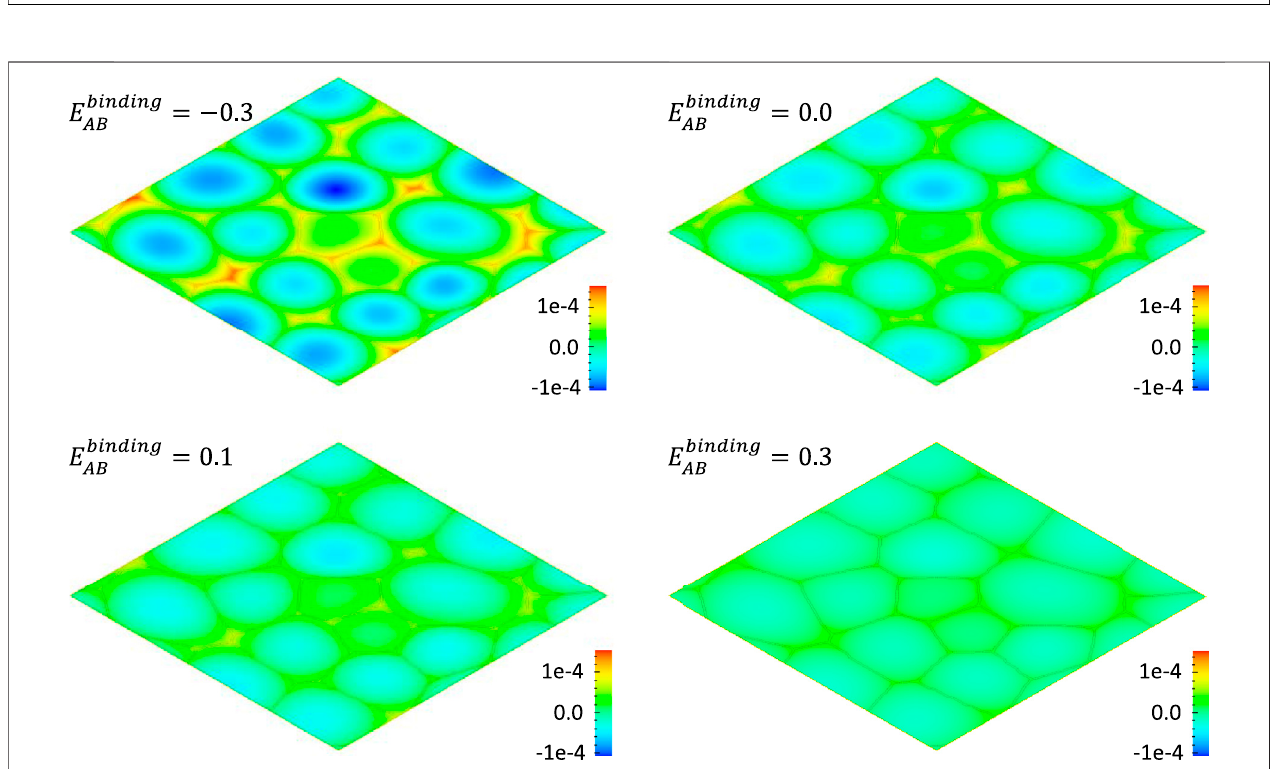
FIGURE 5 | Effect of sink term z d , GB on RIS at time t (cid:2) 8 . 17s. (A) solute concentration change Δ c A , (B) defect concentrations along A 1 A 2 for z d , GB (cid:2) 0 and (C) defect concentrations along A